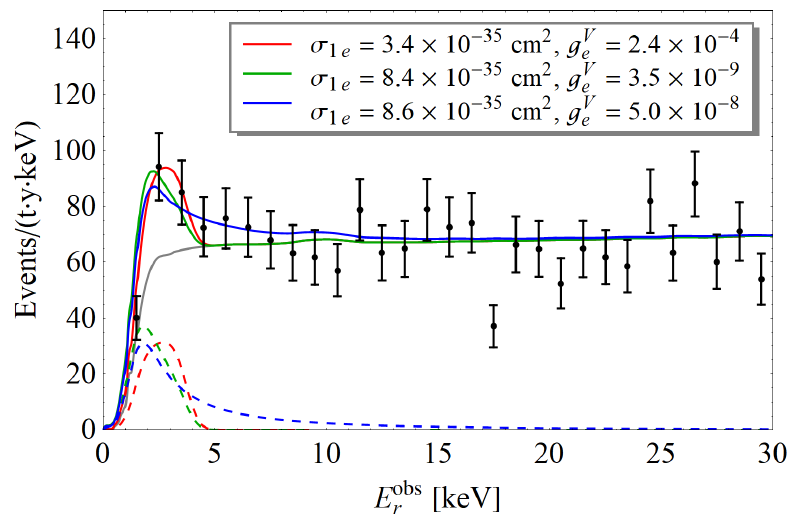
Figure 3 . Sample energy spectra for the same benchmark mass spectra and particle spins